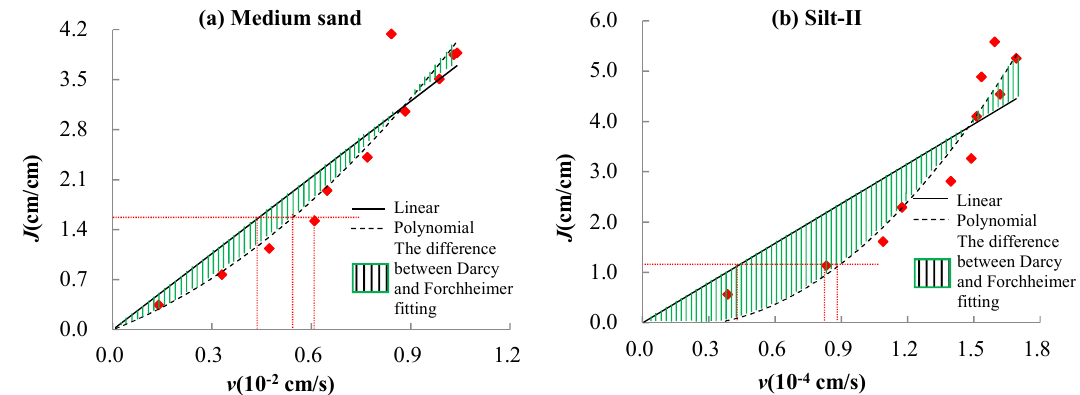
Figure 6. Schematic diagram of the difference between Darcy and Forchheimer fitting for ( a ) medium sand and ( b ) silt-II.